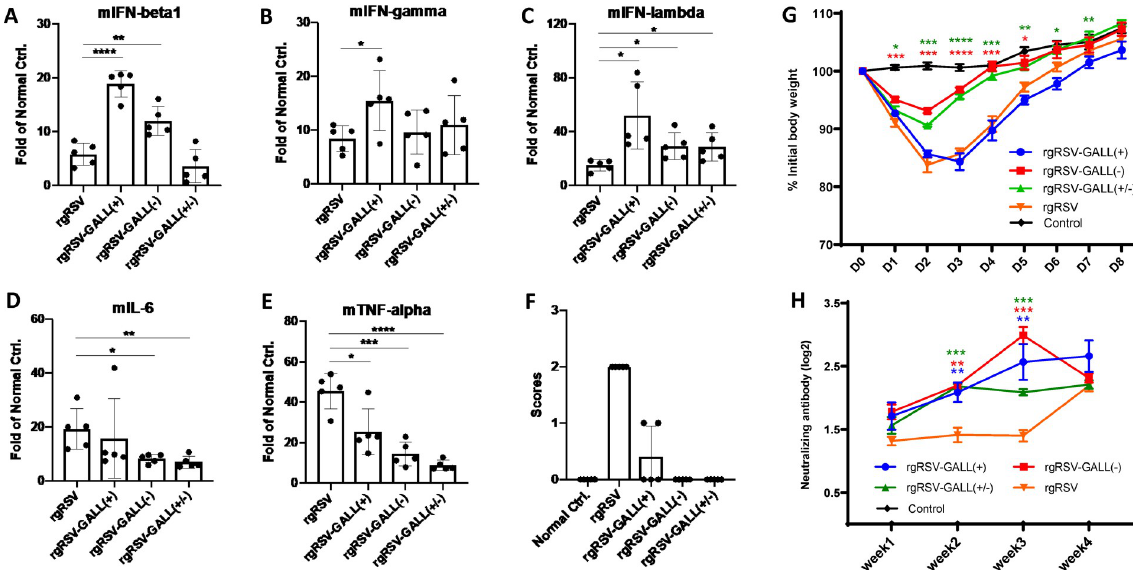
Fig 8. Innate immune response and antibody response of m 6 A-deficient rgRSVs in mice. (A-E) Innate immune response of m 6 A-deficient rgRSVs in mice. 4-week old BALB/c mice were intranasally inoculated with PBS or PBS containing 5 × 10 5 TCID 50 of rgRSV, rgRSV-GALL(+), rgRSV-GALL(-), or rgRSV-GALL(+/-). At 48h post-inoculation, all mice were euthanized, mouse IFN β (mIFN β ) (A), mIFN- γ (B), mIFN- λ (C), mIL-6 (D), and mTNF- α (E) were quantified by real-time RT-PCR. (F) Clinical signs of mice inoculated with recombinant viruses. The severity of clinical signs were scored. Grade 3 (severe) was characterized by ruffled fur, hyperexcitability, tremors, and circling; grade 2 (moderate) was characterized by ruffled fur, hunched posture, and reduced food and water intake; grade 1 (mild) was characterized by mild ruffled fur; and grade 0 was defined as no symptoms. (G) Dynamics of mouse body weight after inoculation with m 6 A-deficient rgRSV. Five 4-6-week-old female BALB/c mice in each group were intranasally inoculated with PBS or 10 6 TCID 50 of rgRSV-GALL(+), rgRSV-GALL(-), rgRSV-GALL (+/-), and parental rgRSV. The body weight for each mouse was evaluated at indicated time points. The average body weights of five mice are shown. (H), The RSV-neutralizing antibody titer was determined using a plaque reduction assay. Cytokine data are the fold change of mice inoculated rgRSV or each rgRSV mutant relative to the normal control mice inoculated with PBS. Data are the mean of 5 mice ( n = 5) ± standard deviation. Antibody titers are the geometric mean titer (GMT) of 5 mice ( n = 5) ± standard deviation. � P < 0.5, �� P < 0.01, ��� P < 0.001, ���� P < 0.0001. Data were analyzed using Student’s t